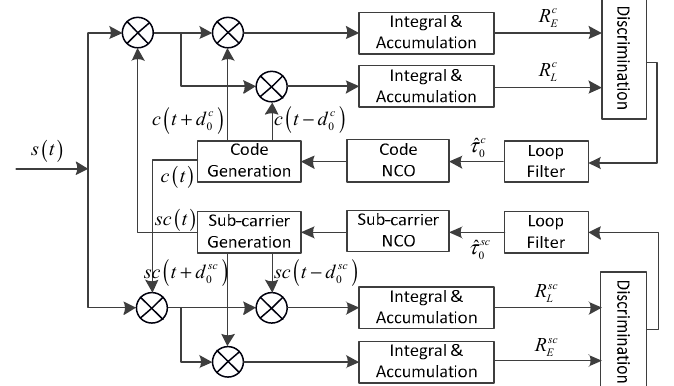
Figure 1. Block diagram of binary offset subcarrier (BOC) signal receiving structure based on double estimation loop.